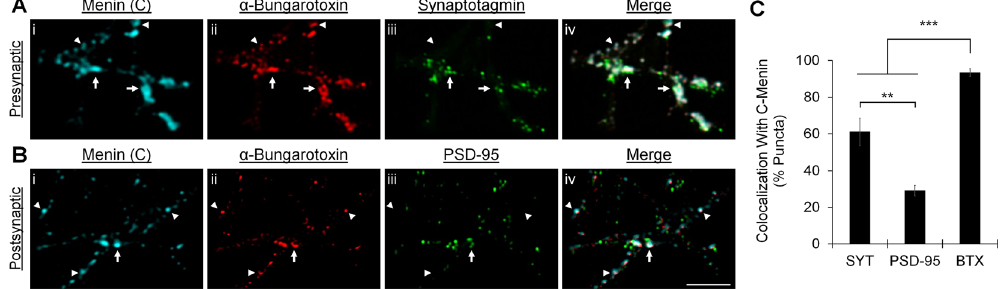
Figure 3. The C-terminal menin fragment colocalizes with α 7 subunit-containing nAChRs at presynaptic terminals. ( A ) Super resolution image of a synaptic ROI at DIV 7 (n = 9 images, 2 independent samples, representative image), cells were labeled with α -C-terminal menin (i), α -bungarotoxin (ii; α 7-nAChR), and α -synaptotagmin (iii; presynaptic marker), (iv) shows merged channels. ( B ) As in ( A ), only labeled with α -PSD- 95 (iii; postsynaptic marker) (n = 10 images, 2 independent samples, representative image). Arrowheads, extrasynaptic colocalization of C-menin and α 7-nAChRs; arrows, synaptic colocalization with synaptotagmin ( A ) or PSD-95 ( B ). Scale bar, 2 μ m. ( C ) Summary data, incidence of colocalization of synaptotagmin (SYT; presynaptic), PSD-95 (postsynaptic), and α -bungarotoxin (BTX; α 7-nAChR) puncta with C-menin. Asterisks, statistical significance (Kruskal-Wallis test); ** P < 0.01. *** P < 0.001. See also Table S2 and Fig.